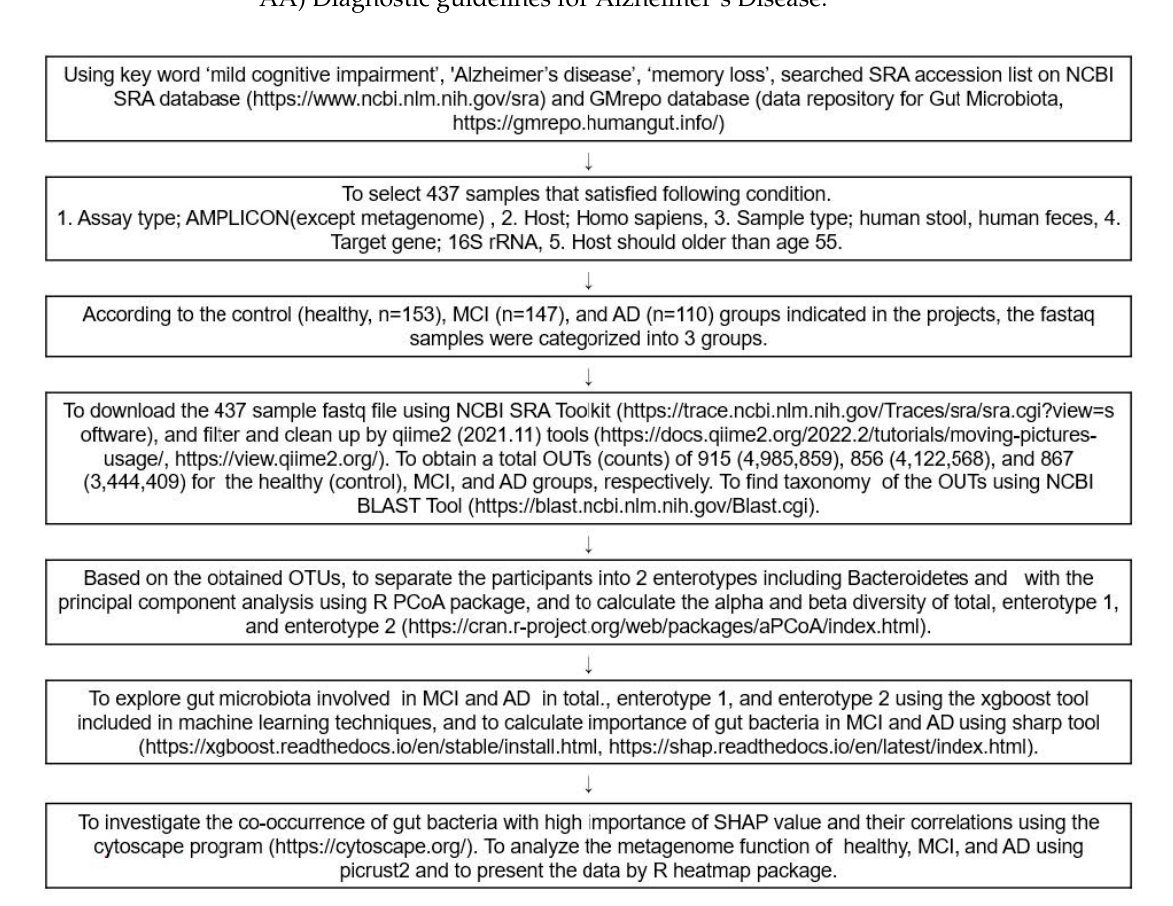
Figure 7. Scheme of the selection and analysis procedures of the fecal bacteria.